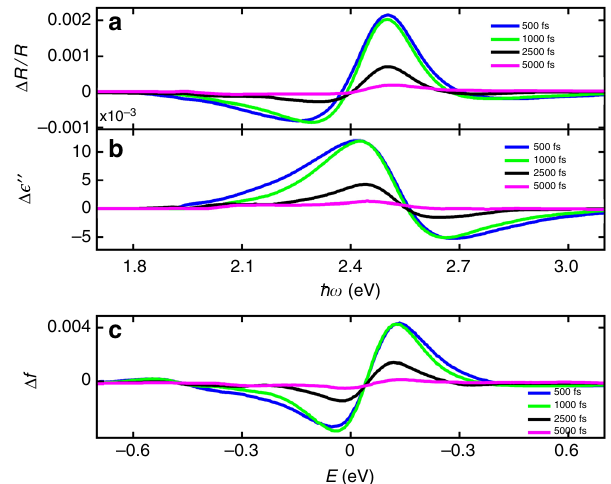
Fig. 4 Spectrum cuts of the data and the inverted quantities. Spectrum cuts at times 500, 1000, 2000, 5000 fs for the normal 30 nm con fi guration: a Δ R / R ( ħ ω ); b Δ ϵ ′′ ( ħ ω ) solved using the integral Eq. (2); c Δ f ( E ) solved using the second integral Eq. (4)